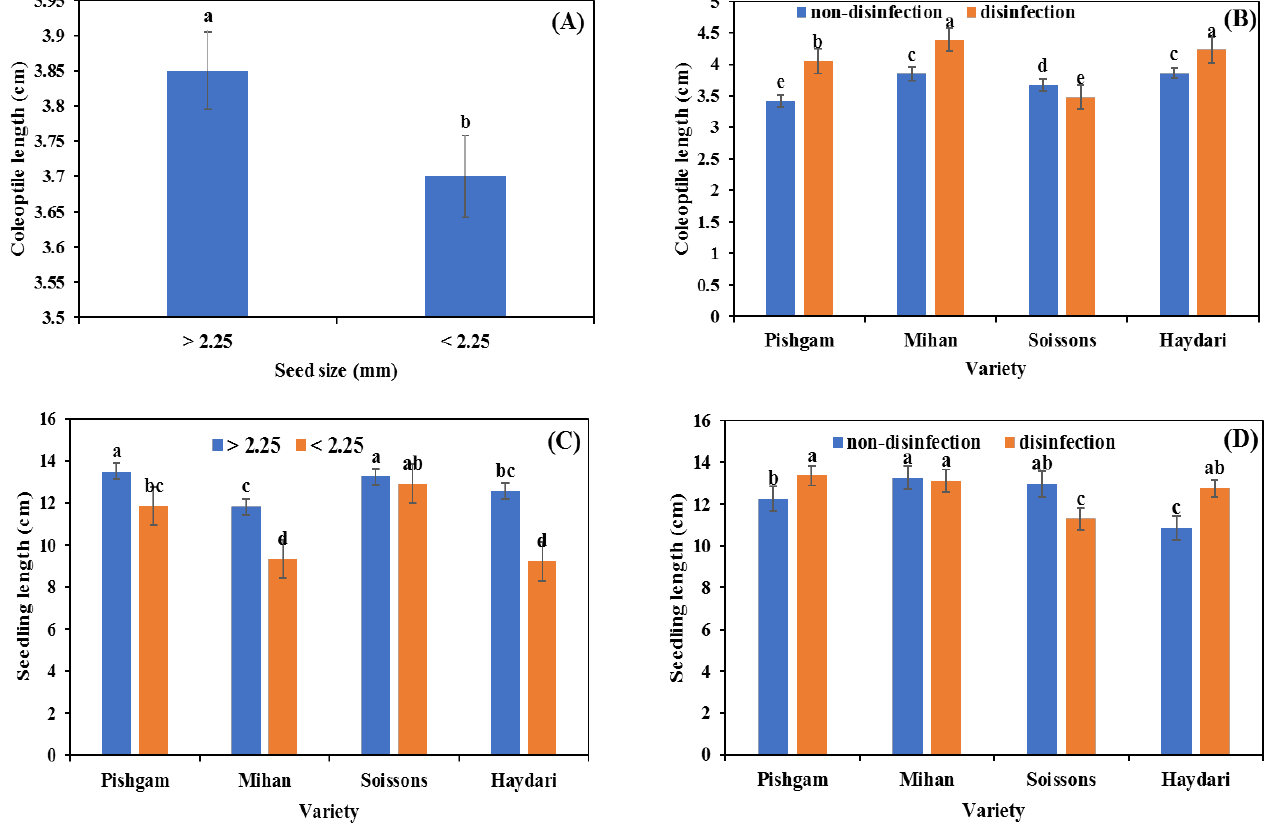
Figure 3. Effect of seed size on coleoptile length ( A ), seed disinfection on coleoptile length ( B ), seed size on seedling length ( C ), and seed disinfection on seedling length in different cultivars ( D ). The columns’ letters indicate the differences between the different treatments ( p < 0.05) using the LSD test. The highest seedling length (ca. 13.94 ± 0.22 cm) was observed in the Pishgam and Soissons cultivars, from seeds larger than 2.25 mm.In contrast, the lowest seedling length (10.95 ± 1.02 cm) was observed in the Haydari and Mihan cultivars from seeds smaller than 2.25 mm (Figure 3C). The highest seedling length (13.42 ± 0.88 cm) was observed in the Pishgam and Mihan cultivars in the seeds that were not disinfected. The shortest length (10.92 ± 1.11 cm) was recorded in plants grown from the Haydari cultivar with seeds that had been disinfected (Figure